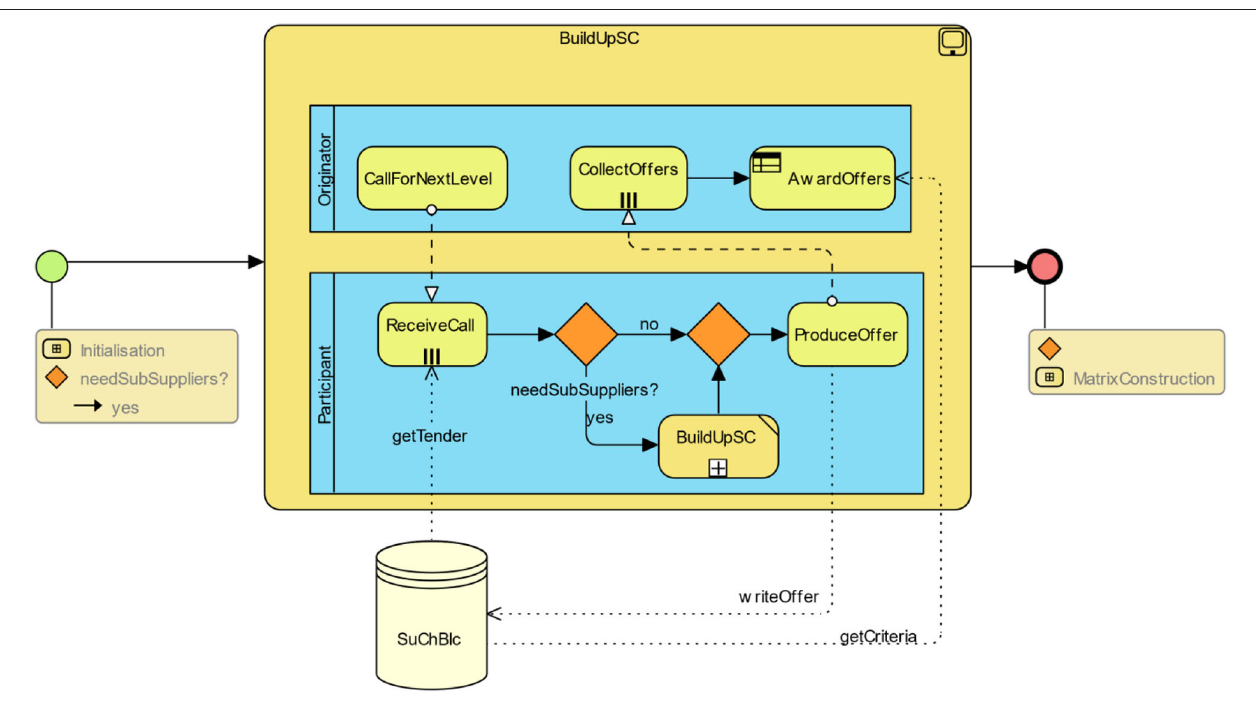
FIGURE 9 | The sub-process for defining the set of participants.